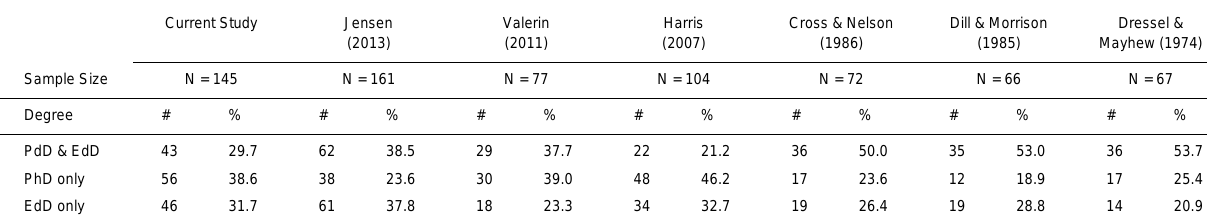
Table 1. Frequency and Proportion of Institutions Offering PhD Only, EdD Only, and Combined PhD/EdD Degrees